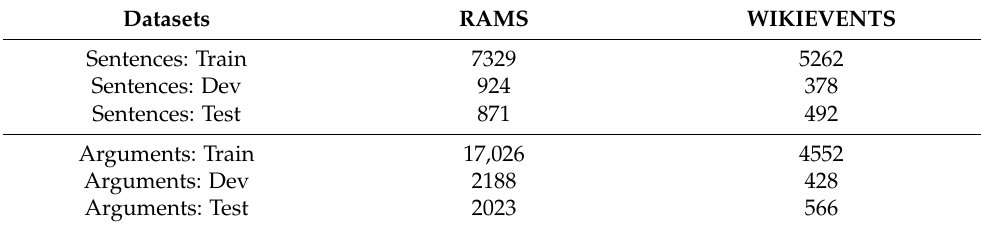
Table 1. Datasets statistics. “Train” denotes training set, “Dev” denotes development set or validation set, and “Test” denotes test